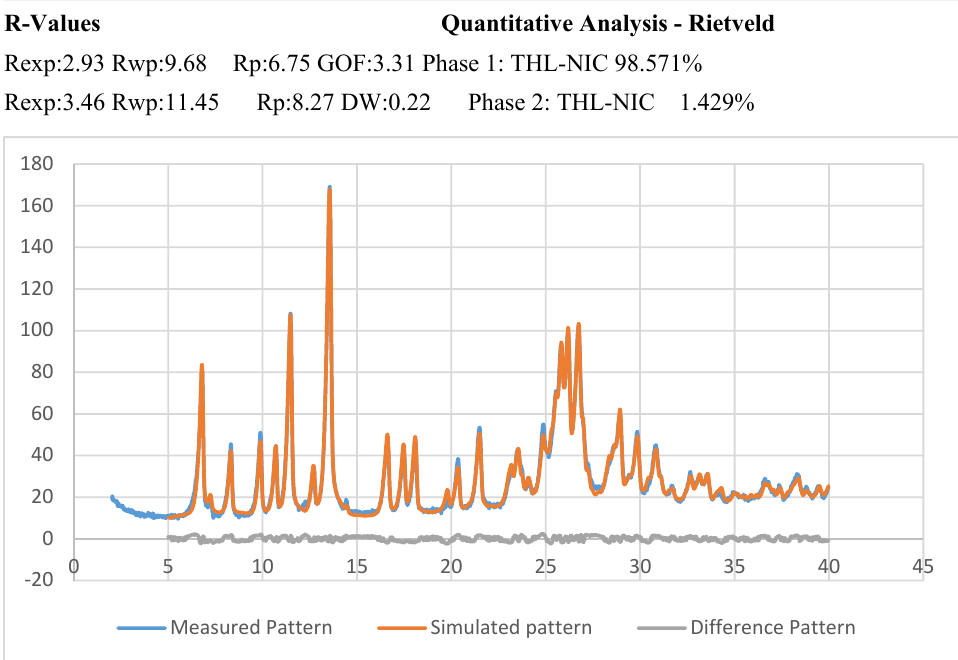
Figure 11. Rietveld refinement of the XRPD data for THL-NIC cocrystals extruded at 500 g/h (Top) and 1.5 kg/h (Bottom), after 12 months at accelerated conditions where the measured pattern is represented with the blue line, the simulated pattern with the red line and the different pattern in grey. Refinement values displayed below.